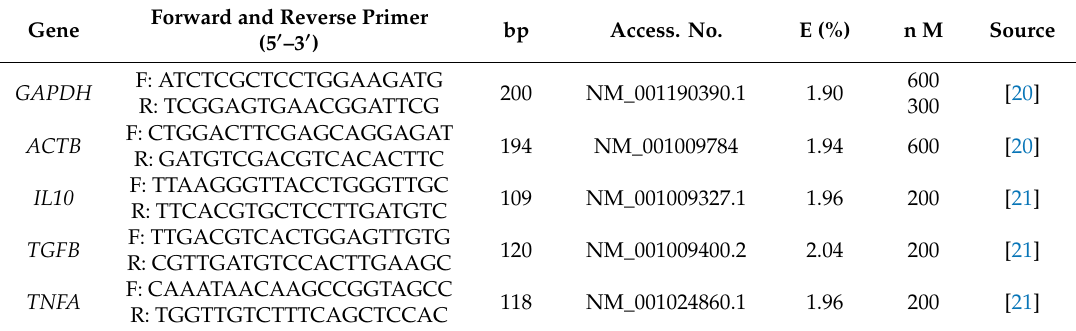
Table 2. Primer Sequences for IL10 , TGFB , TNFA , GAPDH and ACTB Used for Quantitative Real-Time